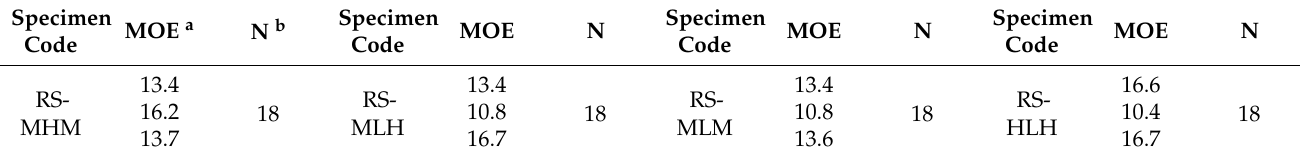
Figure 1. Test configuration for the planar shear test. ( a ) Specimens geometry, ( b ) Test specimen, ( c ) Test specimens during testing. Table 2. Detail of sample for planar shear